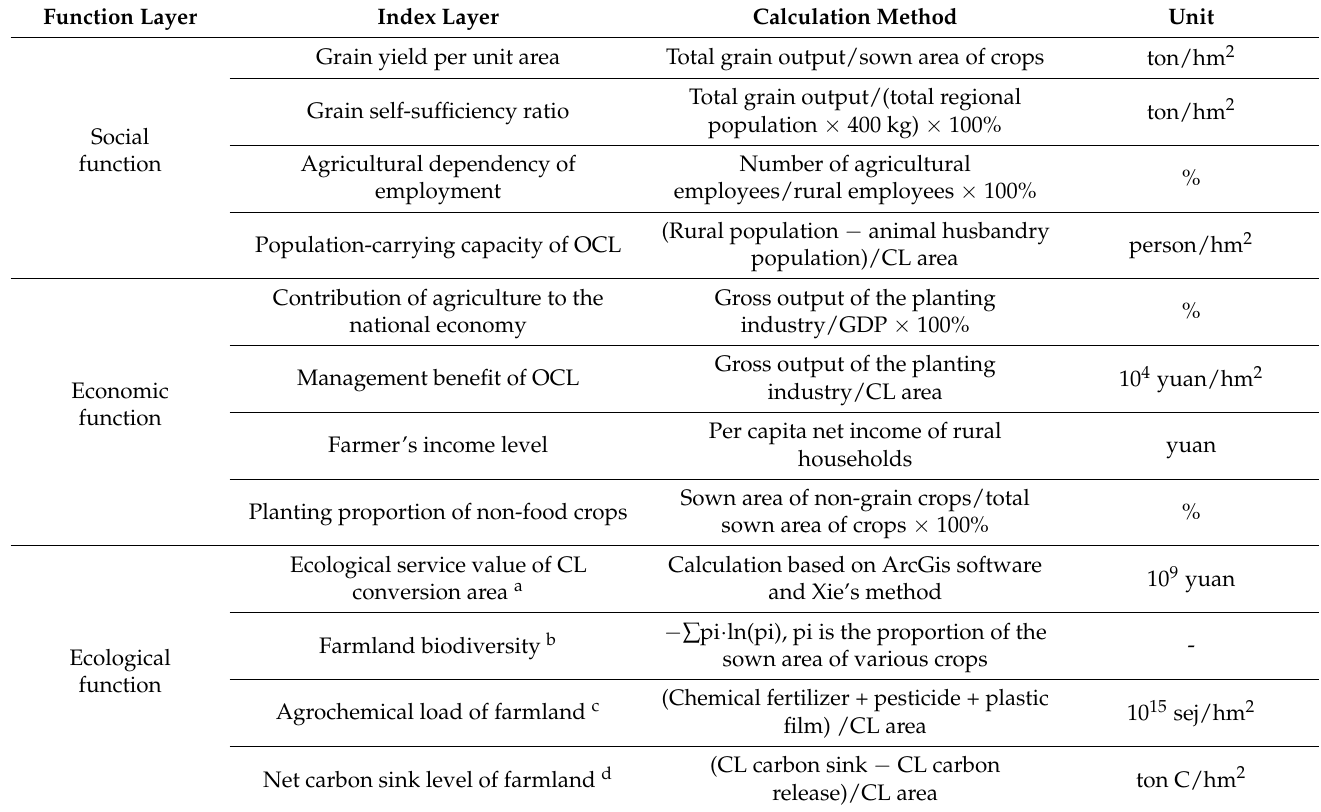
Table 1. Evaluation index system of oasis cultivated land function in